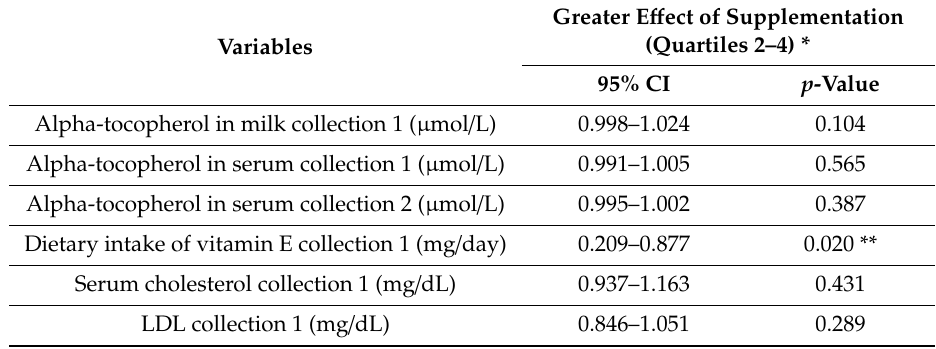
Table 3. Binary logistic regression model for variables associated with greater e ff ect of 800 IU alpha-tocopherol supplementation in breast milk in the supplemented group.